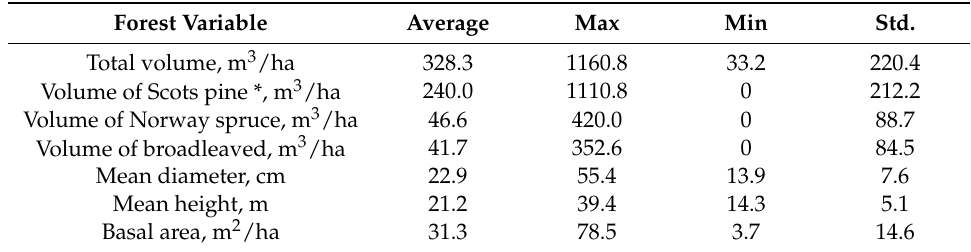
Table 1. Average, maximum (Max), minimum (Min) and standard deviation (Std.) of field variables in the field data in the study area.